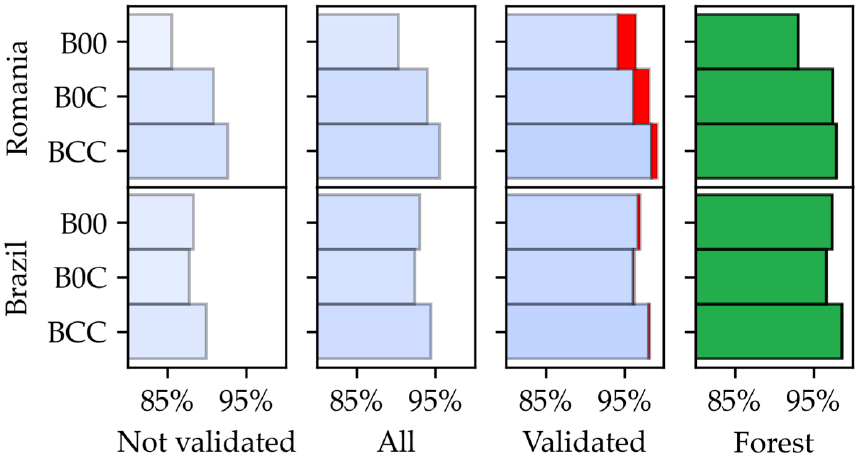
Figure 12. Percentage of pixels with no change between the 2018–2019 classifications segregated in: “Not validated”—pixels with no validation label, “all”—all pixels (with or without validation label), “validated”- pixels with validation labels, and “forest”—pixels whose validation label was forest (green). Blue bars denote stability. In the case of validated subset, the blue bar indicates accurate and stable pixels, whereas red indicates stable but misclassified pixels.